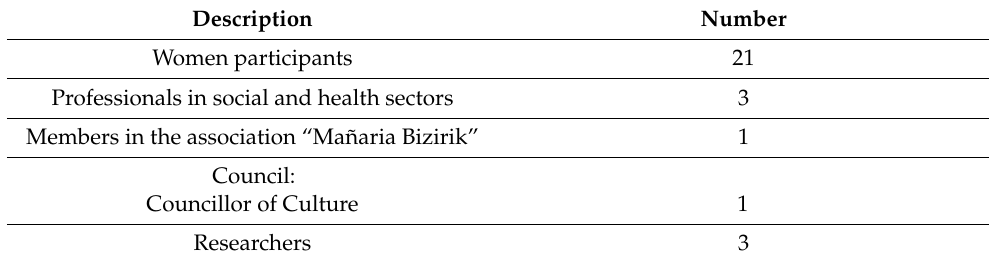
Table 1. Actors involved in